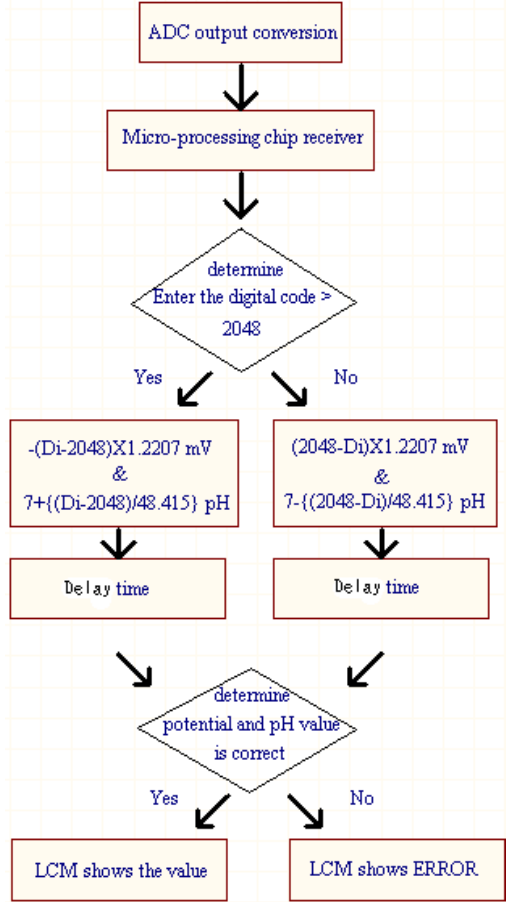
Figure 5. The internal operation of P89C51 for pH